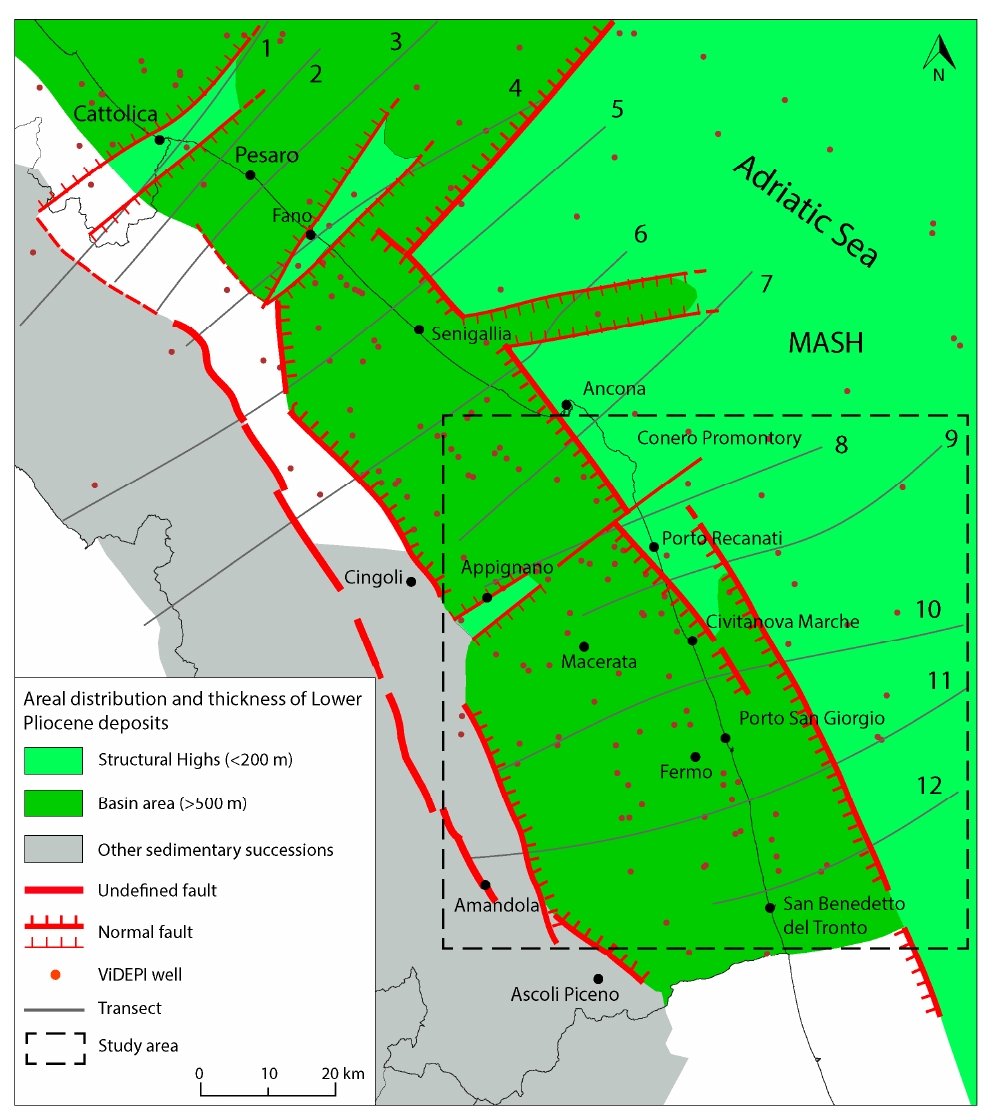
Figure 9. Schematic map of the distribution and thickness of Lower Pliocene deposits within the Marche region and the adjacent Adriatic Sea. Marche Adriatic Structural High (MASH) and smaller structural highs and basins are highlighted with the same colour. The study area is located in the dashed square.